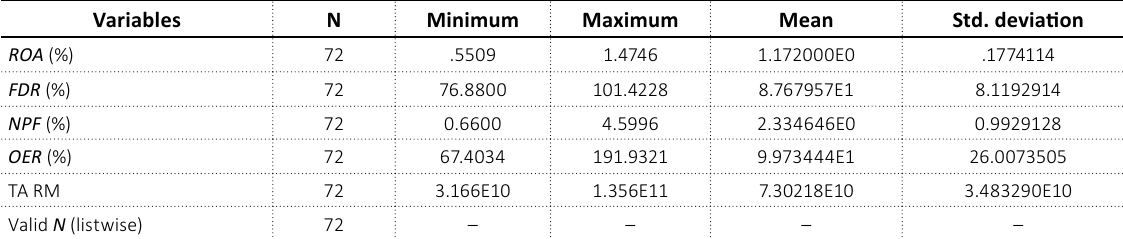
Table 5. Descriptive statistics of Malaysian Islamic